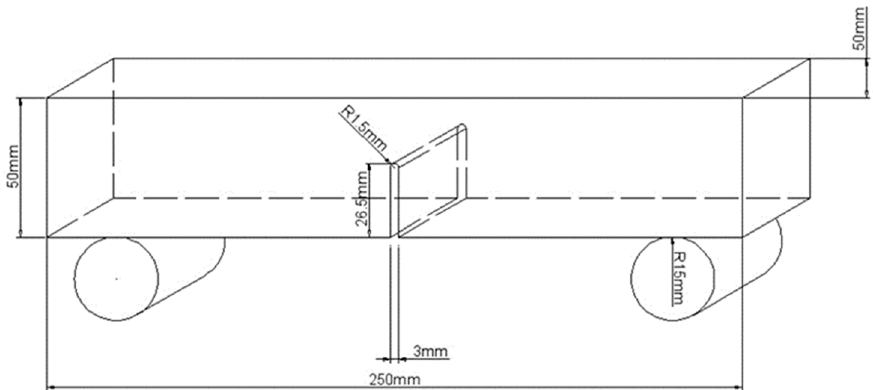
Figure 1. Three-point bending test specimen.